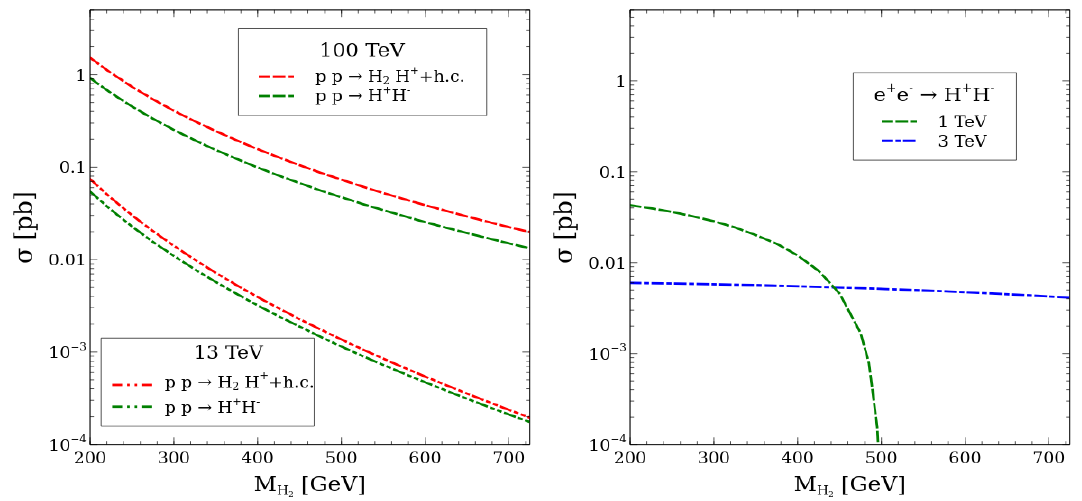
√ s = 13 TeV LHC. RP: production √ √ s = 1 TeV and s = 3 TeV. The maximum luminosity